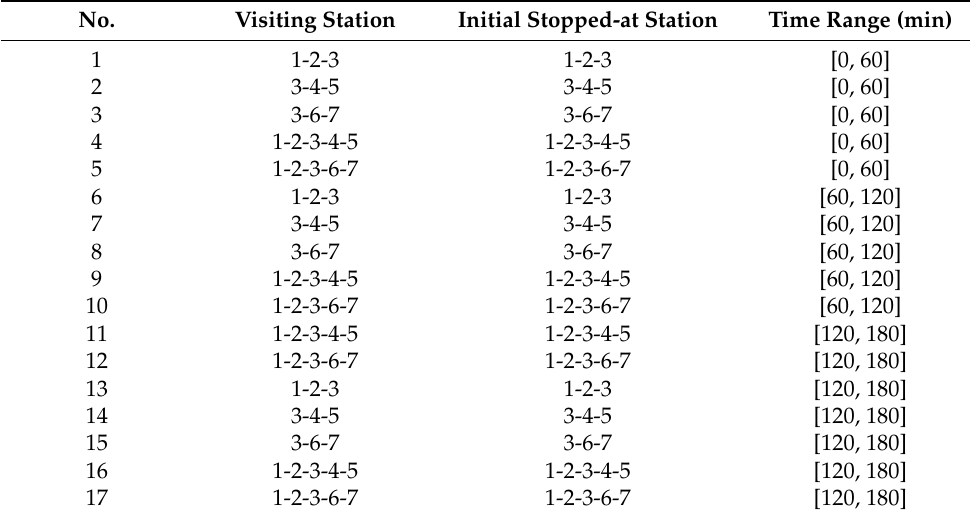
Figure 4. Trains’ pure running times on the toy railway network. Table 3. The information of the candidate